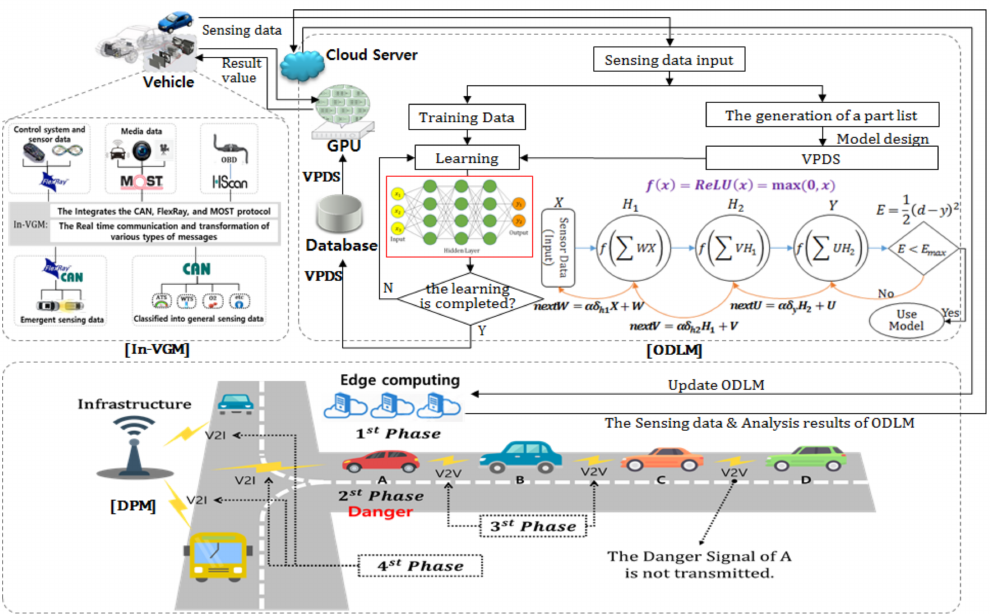
Figure 3. The Structure of an Integrated Self-diagnosis System